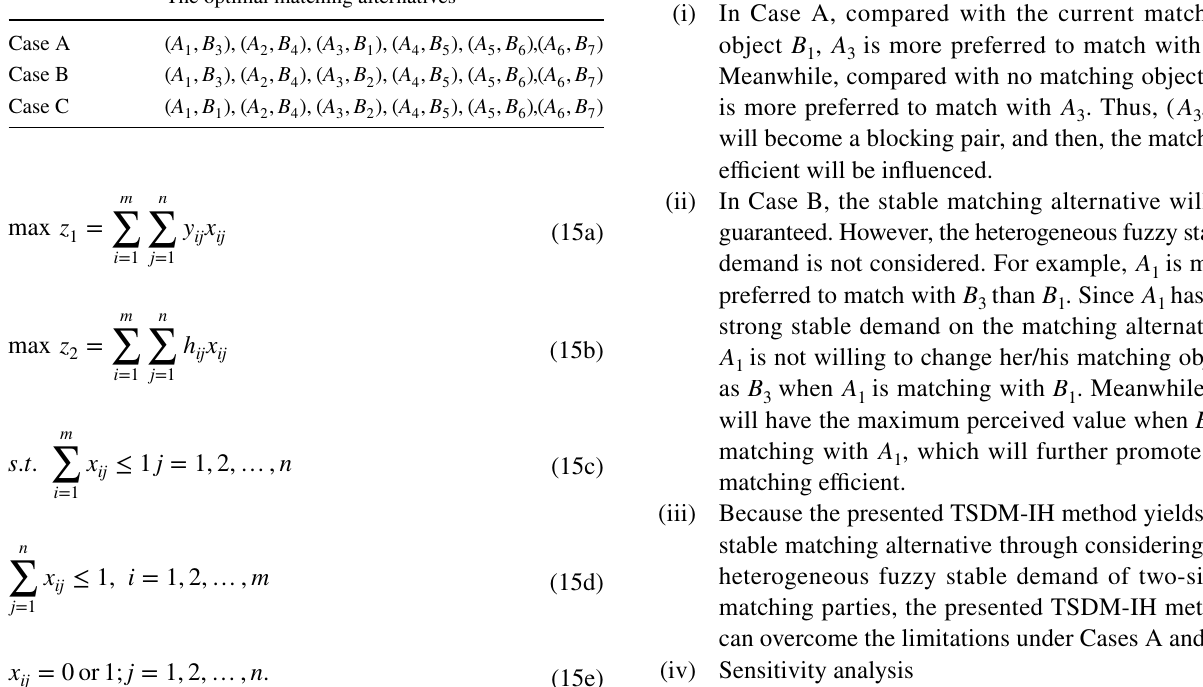
Table 11 The obtained matching alternatives under different cases The optimal matching